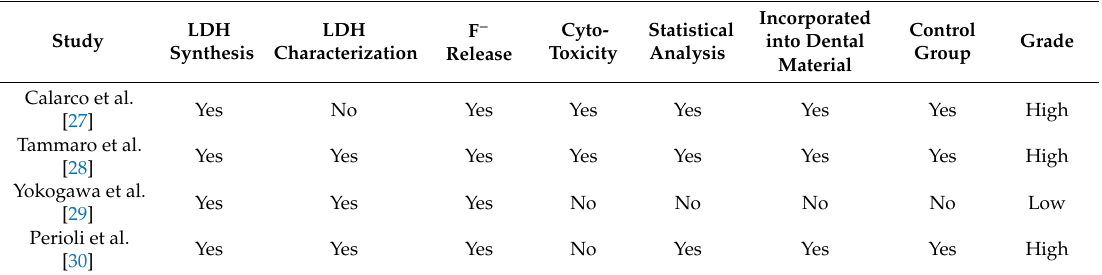
Table 2. Methodological quality of the selected